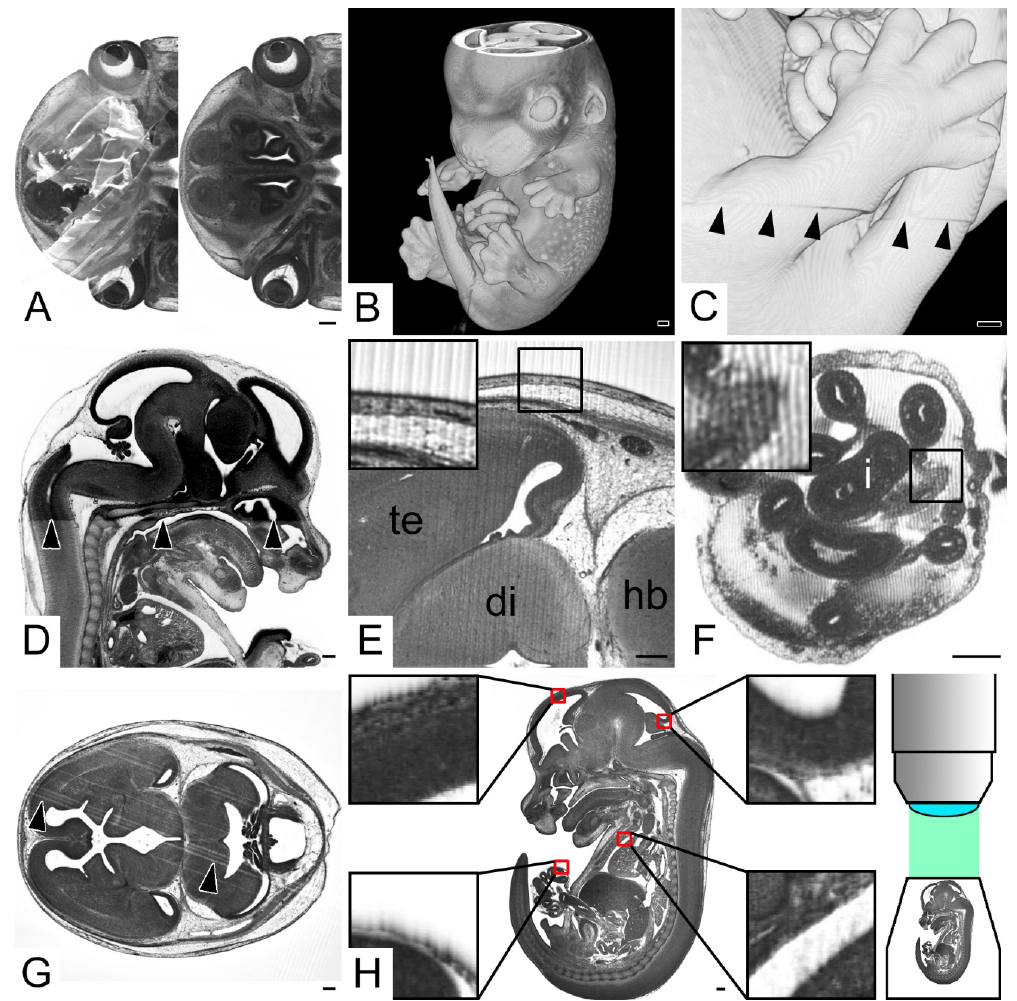
Figure 5. Data generation artefacts. ( A ) Original HREM section image partly obscured by unremoved section. ( B ) Volume model of embryo missing images from top of the head ( C ) Misalignment between stacks of consecutive HREM images (arrow heads). A 3D model from right. ( D ) Change of image contrast (arrow heads) at the level of the hard palate. Sagittal resection, ventral to the right. ( E , F ) Straight ( E ) and wave-like ( F ) lines perpendicular to the cutting direction in original HREM images. ( G ) Scratches in original HREM sections running in parallel to the cutting direction. ( H ) “Bleeding through”. Sagittal resection, ventral to the left. Inlays show magnifications of areas inside the red boxes. The cranial borders of darkly stained structures appear as fading into cavities in the direction of the image capturing optics. Note the scheme of the optical setup indicating that the embryo is imaged from cranial to caudal. Abbreviations: di: diencephalon, hb: hindbrain, i: intestine, te: telencephalon. Scale bars = 250 µ